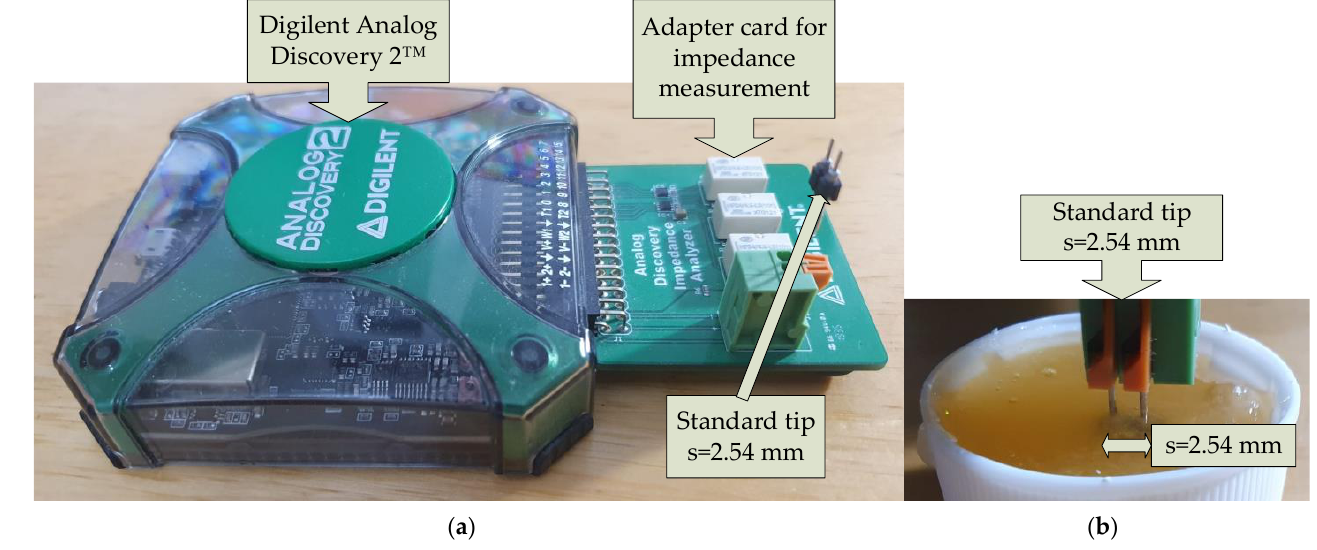
Figure 1. Device used for impedance measurement: ( a ) DAD2, the adapter card for impedance measurement; ( b ) standard tip used of s = 2.54 mm in length and equal separation.